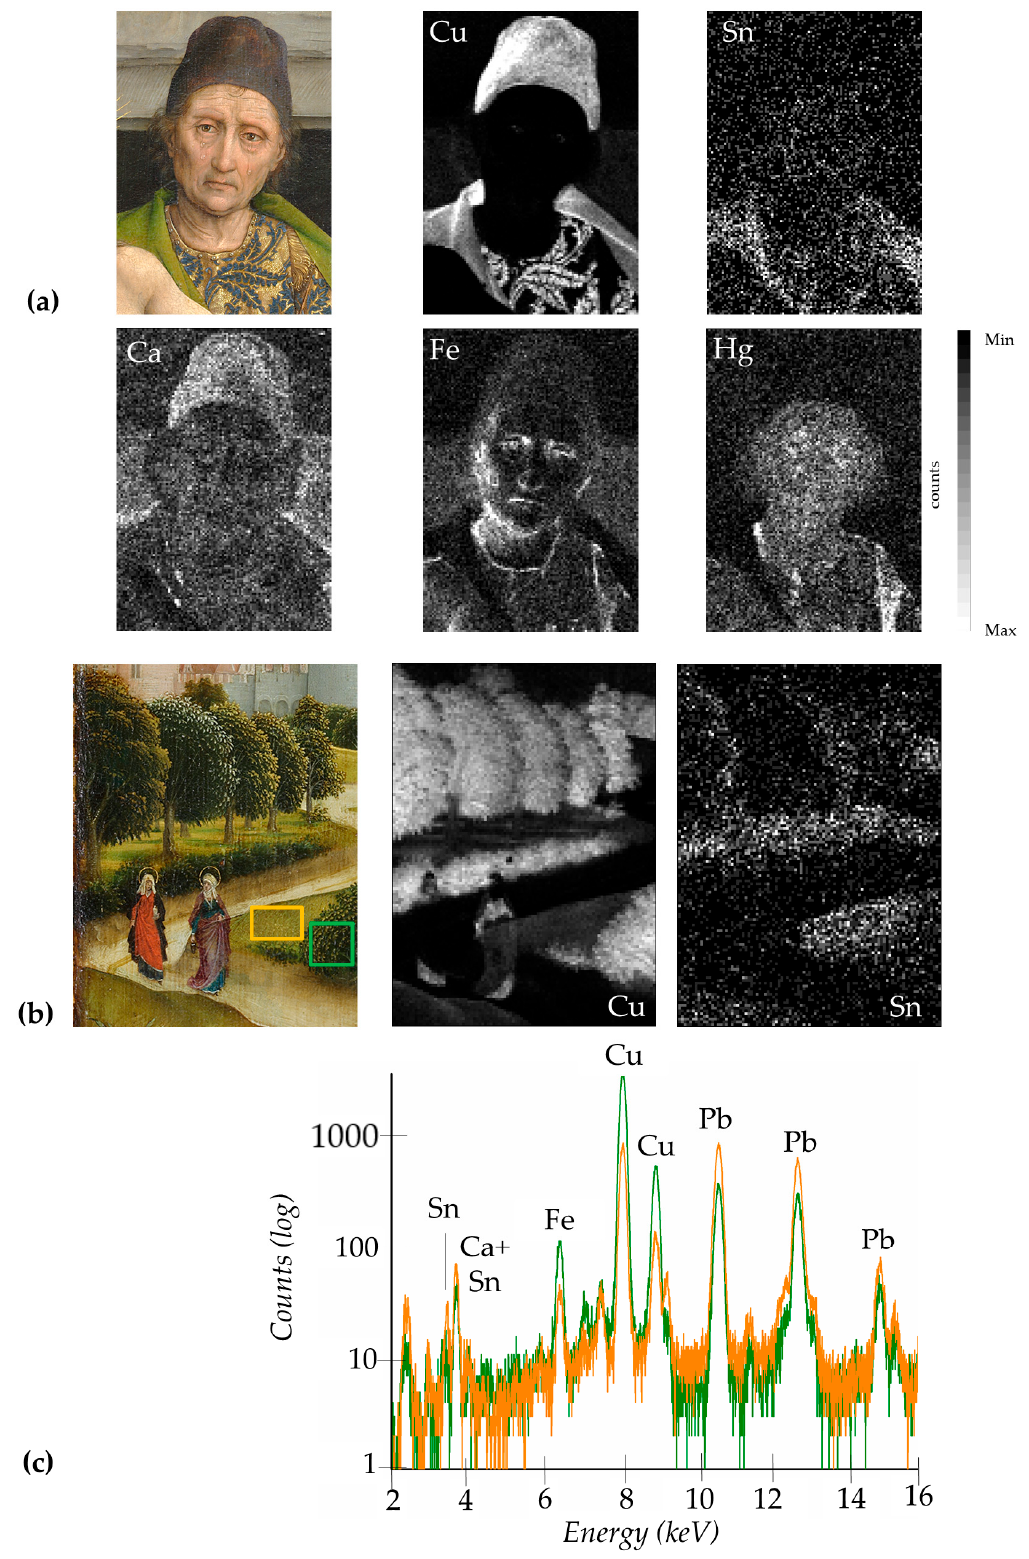
Figure 5. ( a ) Detail of Nicodemus, with relative Cu(K α ), Sn(L α ), Ca (K α ), Fe(K α ), and Hg(L α ) XRF maps; ( b ) detail of the upper left landscape, with relative Cu(K α ) and Sn(L α ) XRF maps; ( c ) spectra of the green and yellowish landscape, relative to the areas indicated in detail ( b ). The two ROI are roughly of the same area in